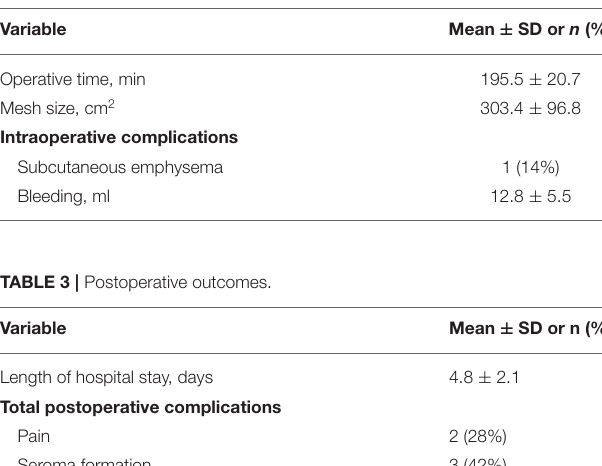
TABLE 2 | Intraoperative parameters.